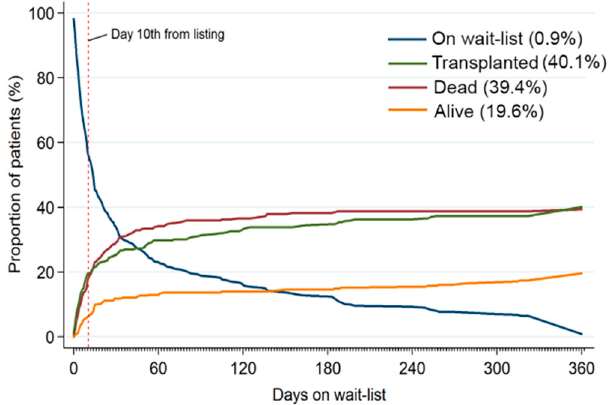
Figure 2. Competing outcomes of transplant, death, and survival show the chance for transplantation